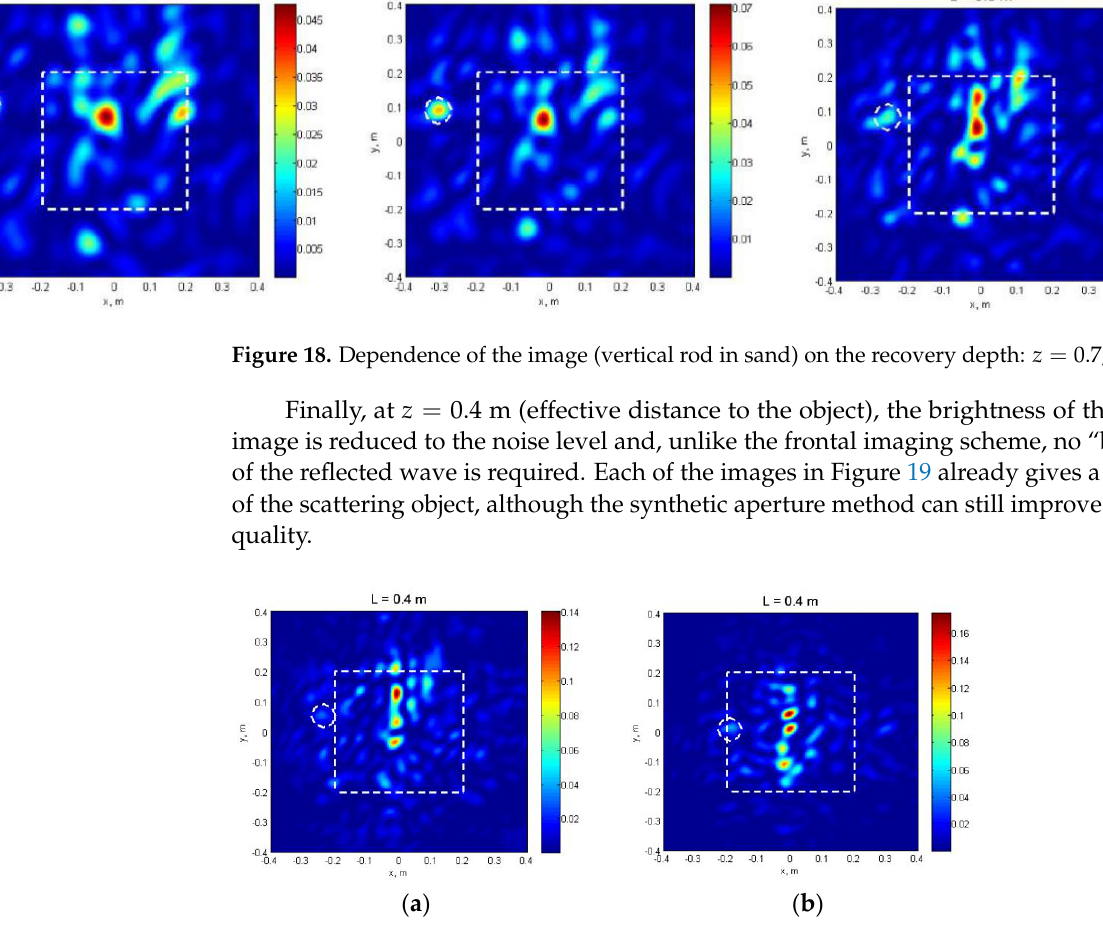
( b ) Figure 17. Geometry of oblique probing ( a ); imaginary source does not irradiate HSR aperture ( b ). Notations: radiator, R; object, O; holographic antenna, A; mirror source image, M. Arrows mark the